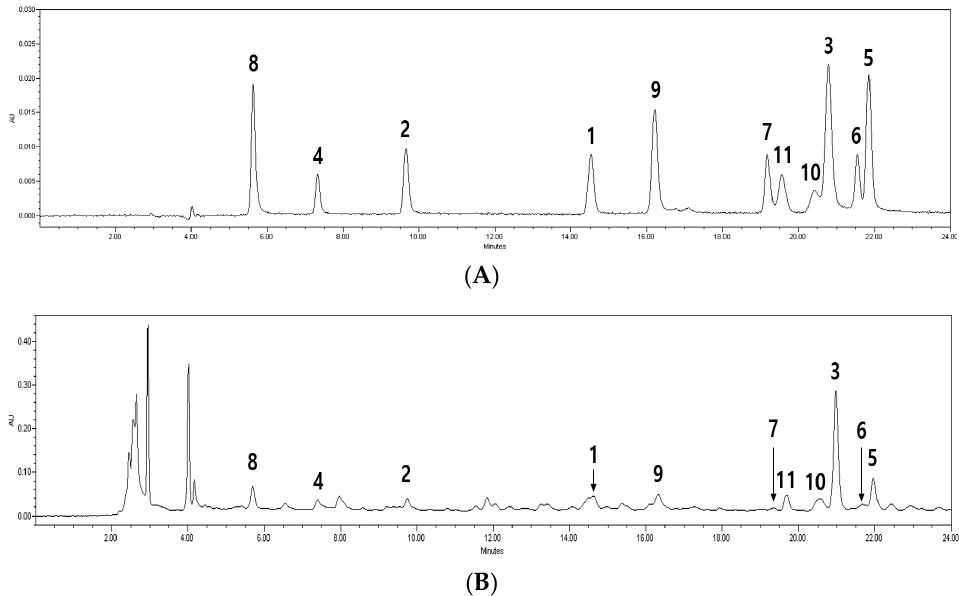
Figure 1. High-performance liquid chromatography ( HPLC) chromatograms of standard mixtures ( A ) and Benincasae Exocarpium extracts ( B ). Compound 8 (gallic acid); Compound 4 (5-hydroxymethylfurfural); Compound 2 (protocatechuic acid); Compound 1 ( p -hydroxybenzoic acid); Compound 9 (caffeic acid); Compound 7 (orientin); Compound 11 (vitexin-4 (cid:48)(cid:48) - O -glucoside); Compound 10 (vitexin-2 (cid:48)(cid:48) - O -rhamnoside); Compound 3 (Isovanillin); Compound 6 (vitexin); Compound 5